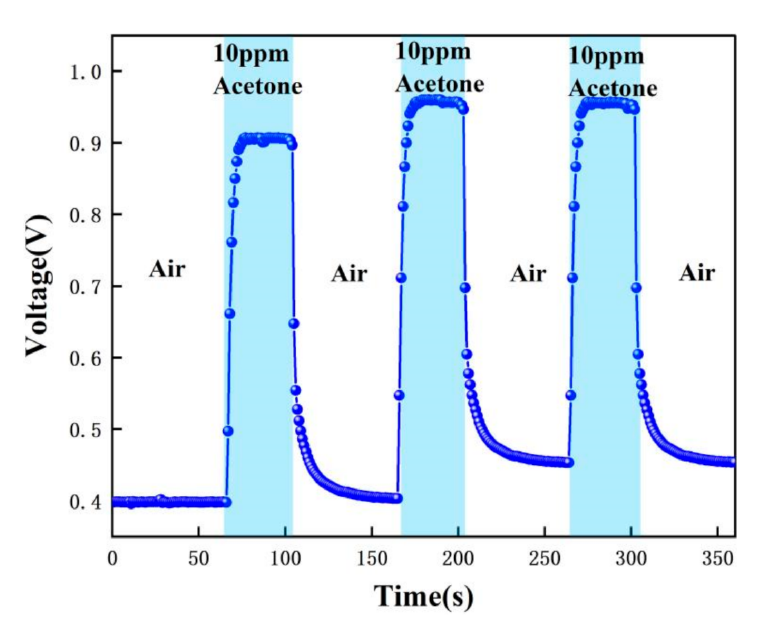
Figure 16. Test result of 10 ppm